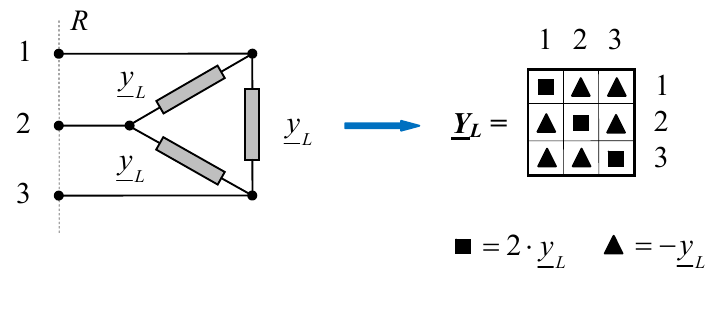
Figure A2. Model of complex load at receiving